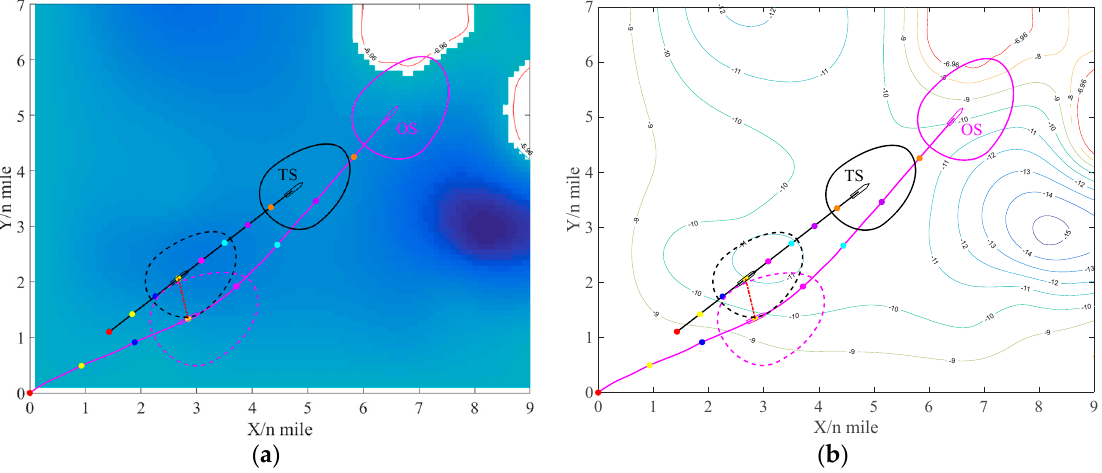
Figure 13. Local path planning in overtaking situation. ( a ) Navigable map. ( b ) Depth contour.